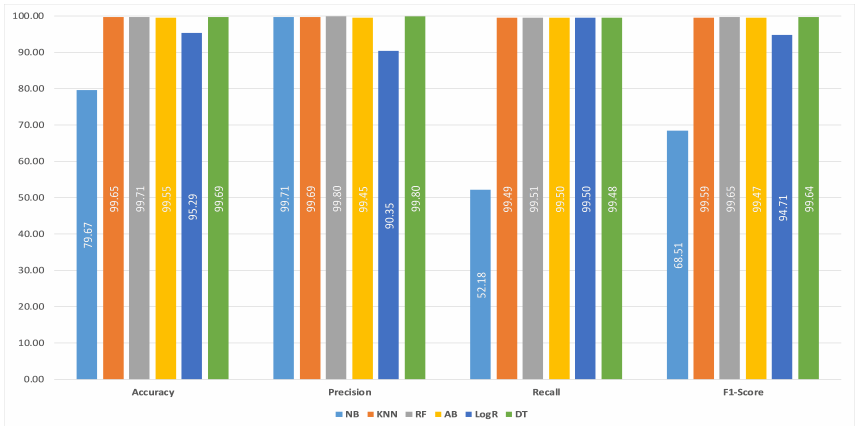
Figure 6. Performance comparison of six commonly used machine learning classifiers for malicious traffic detection over IoT healthcare dataset.